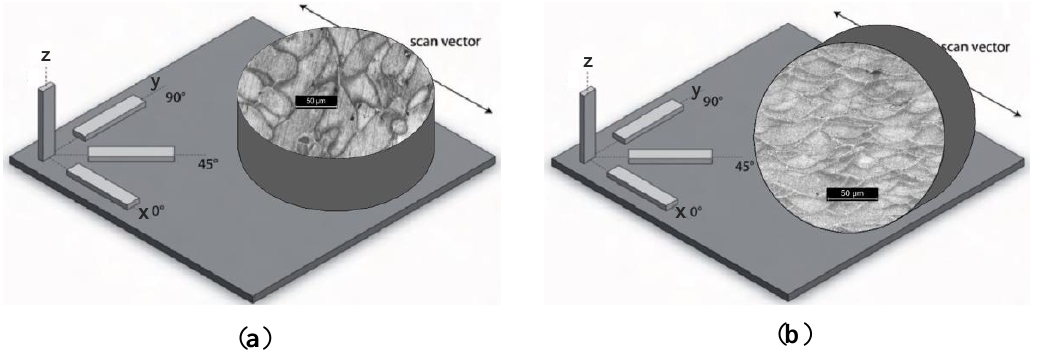
Figure 1. Schematic representation of specimens built with ( a ) the base parallel to building platform (XY specimens) and ( b ) perpendicular to the building platform (XZ specimens).